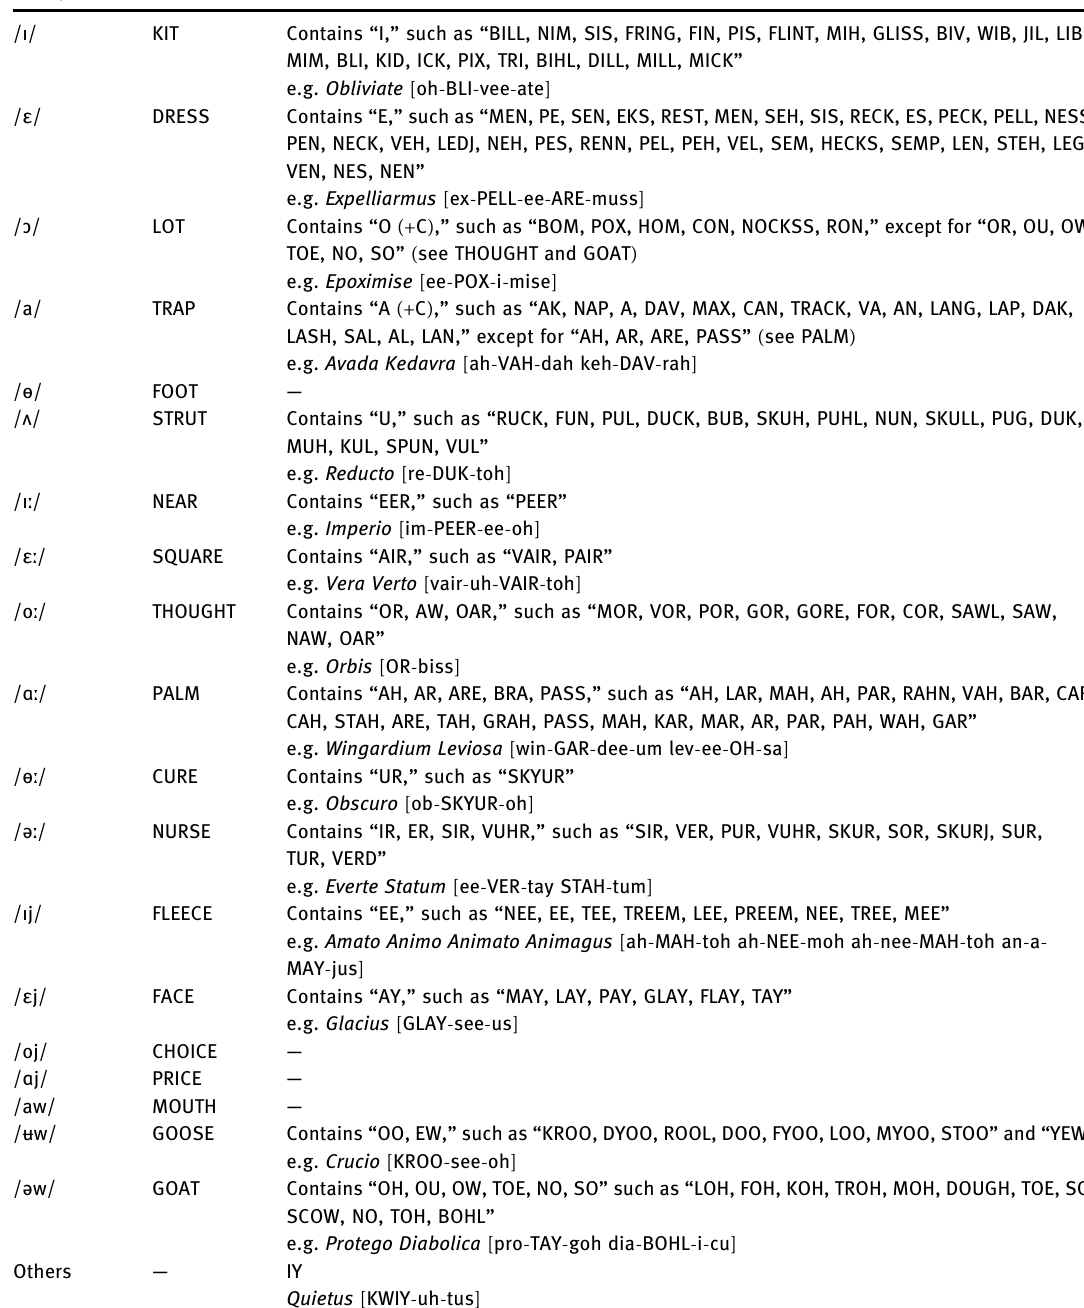
Table 1: IPA symbols and targeted letters IPA symbols Lexical